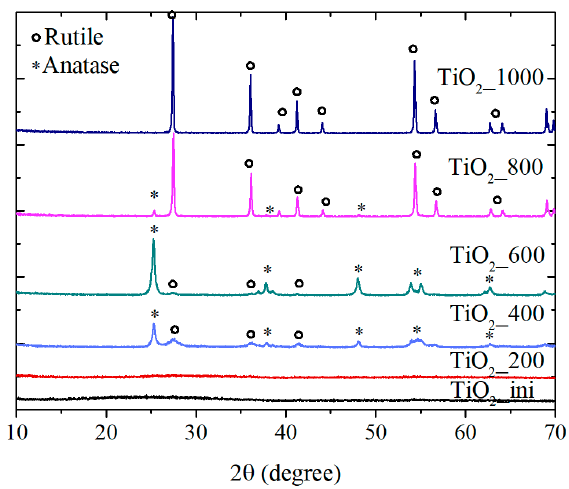
Figure 2. XRD patterns of the samples.